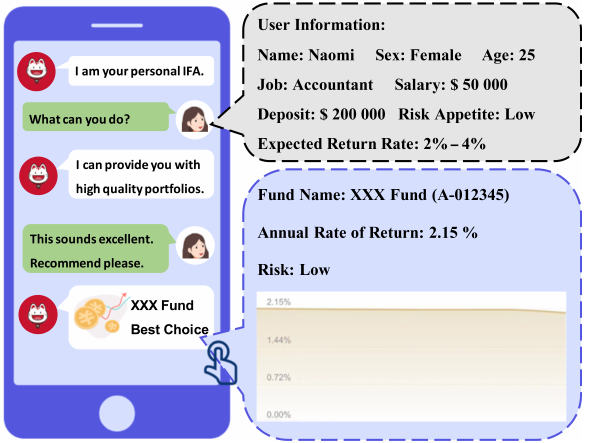
Fig. 1 A scenario that takes place between a user and an IFA.